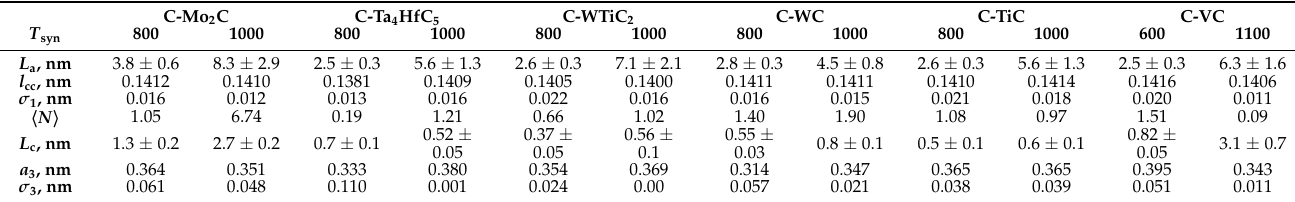
Table 2. Parameters derived from WAXS patterns for some CDCs. L a –average graphene layer extent, l cc –average C-C bond length, σ 1 –standard deviation of the first-neighbor distribution, 〈 N 〉 –average number of graphene layers per stack, L c –average stacking size, a 3– average interlayer spacing, σ 3 –standard deviation of interlayer spacing.